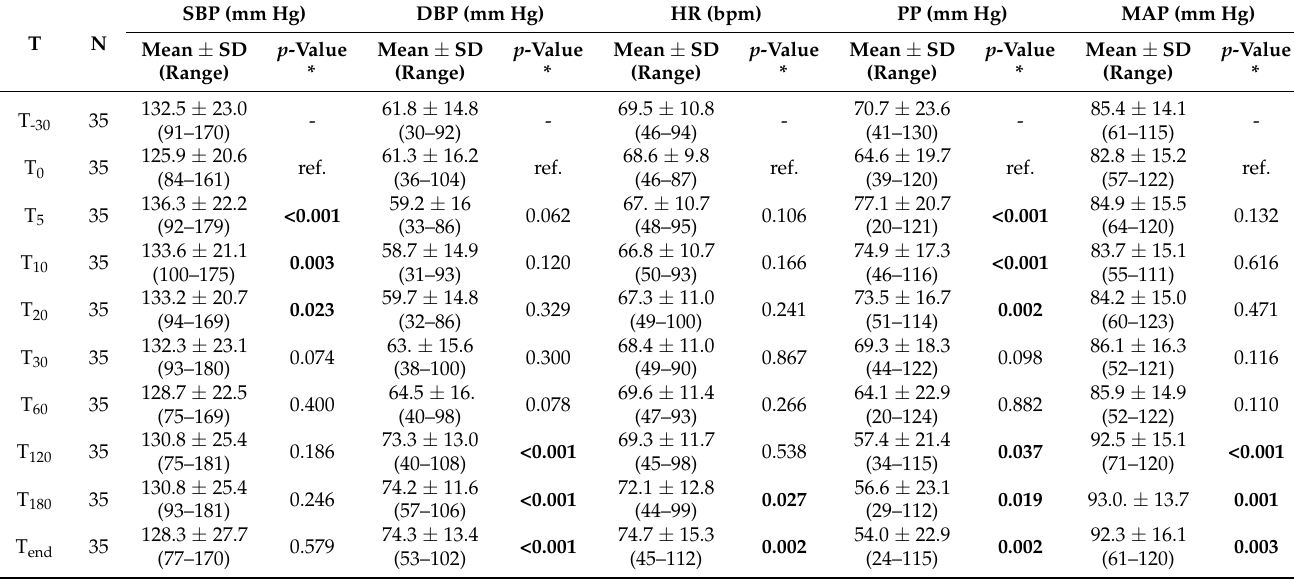
Table 2. Hemodynamic parameters during hemodialysis.